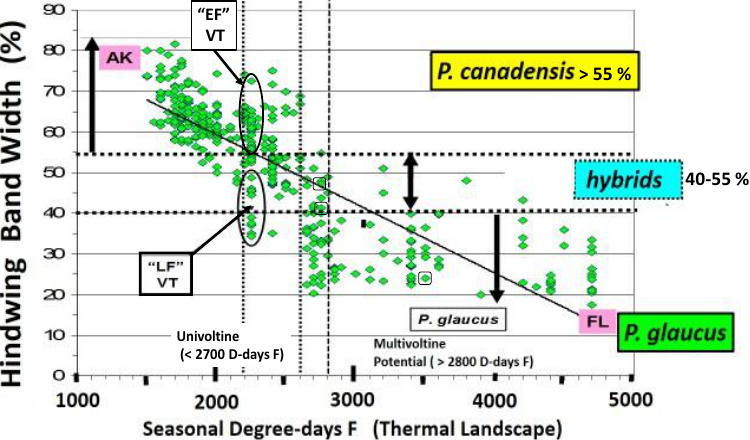
Figure 14. The mean annual male hindwing bands of P . glaucus , P . canadensis , and likely hybrids as a function of summer D-day (F) totals from Alaska (left, at 65° N latitude) to (cid:41)(cid:79)(cid:82)(cid:85)(cid:76)(cid:71)(cid:68)(cid:3) (cid:11)(cid:85)(cid:76)(cid:74)(cid:75)(cid:87)(cid:30)(cid:3) (cid:68)(cid:87)(cid:3) (cid:21)(cid:26)(cid:131)(cid:3) (cid:49)(cid:3) (cid:79)(cid:68)(cid:87)(cid:76)(cid:87)(cid:88)(cid:71)(cid:72)(cid:12)(cid:17)(cid:3)(cid:55)(cid:75)(cid:72)(cid:3) (cid:57)(cid:72)(cid:85)(cid:80)(cid:82)(cid:81)(cid:87)(cid:3) (cid:179)(cid:47)(cid:41)(cid:180)(cid:3) (cid:11)(cid:79)(cid:68)(cid:87)(cid:72)(cid:3) (cid:73)(cid:79)(cid:76)(cid:74)(cid:75)(cid:87)(cid:3) (cid:75)(cid:82)(cid:80)(cid:82) ploid recombinant hybrids, in July) and the EF (early flight of P . canadensis in mid-May to June) are basically sympatric, but separated temporally by 3 (cid:177) 5 weeks [24,100]. The hybrid species, P . appalachiensis is indicated by squares at 2,800 D-days, with the nearly sympatric P . glaucus of lower elevations at 3,500 D-days in Pendleton Co. The correlation is significant (R² = 0.6669, n = 277 population means).